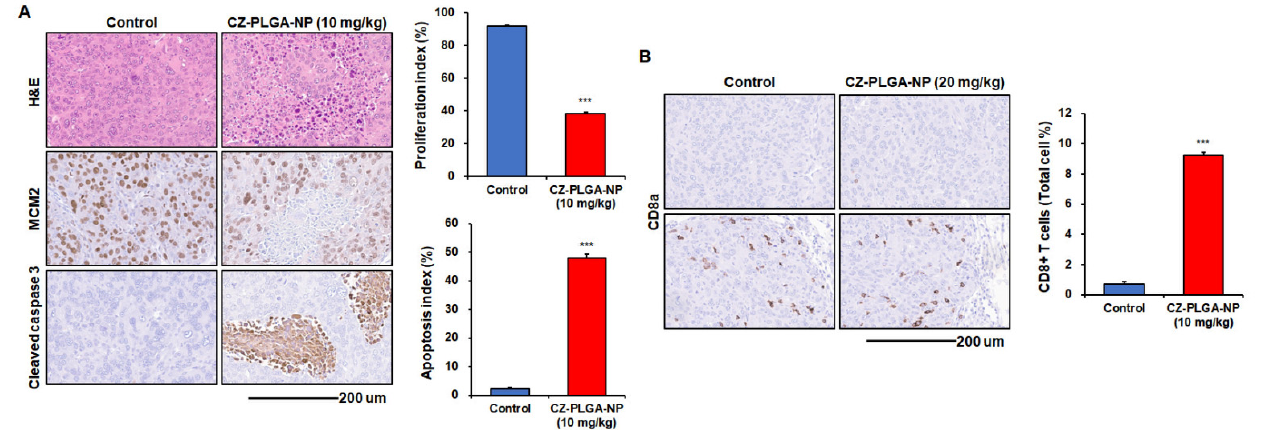
Figure 8. In vivo effects of CZ-PLGA-NPs on Renca-SRLu5-Luc tumor cell proliferation, apoptosis, and CD8+ T cell infiltration into lung metastasis in an experimental Renca-SRLu5-Luc lung metastasis model. ( A ) Representative images of hematoxylin–eosin (H&E) and immunohistochemical (IHC) staining for MCM2 and cleaved caspase-3 in Renca-SRLu5-Luc lung metastases (right panel). Proliferative cells stained with MCM2 and apoptotic cells stained with anti-cleaved caspase-3 antibodies in tumors. Positive staining appears as a brown color. Scale bar = 100 µ m. Quantification of IHC staining for MCM2 and cleaved caspase-3 (left panel); ( B ) Representative IHC staining (anti-CD8 α +, brown color, right panel) and quantitative analysis (left panel) of cytotoxic CD8+ T cell infiltrates into the lung metastases in the Renca-SRLu5-Luc model. Scale bar = 100 μ m. All groups, n ≥ 5; data are presented as the mean ± standard error of the mean. *** p < 0.001; treated vs. control groups. Scale bars = 200 mm.